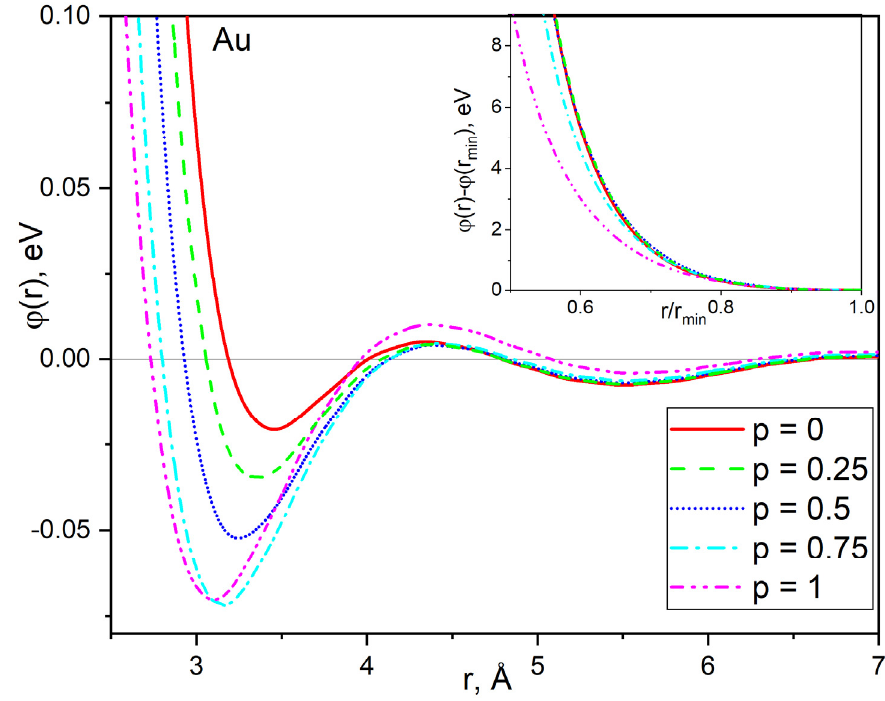
Figure 7. Pair potentials for liquid Au at T = 1423 K at different p . Inset: the repulsive part of ϕ ( r ) in reduced units.